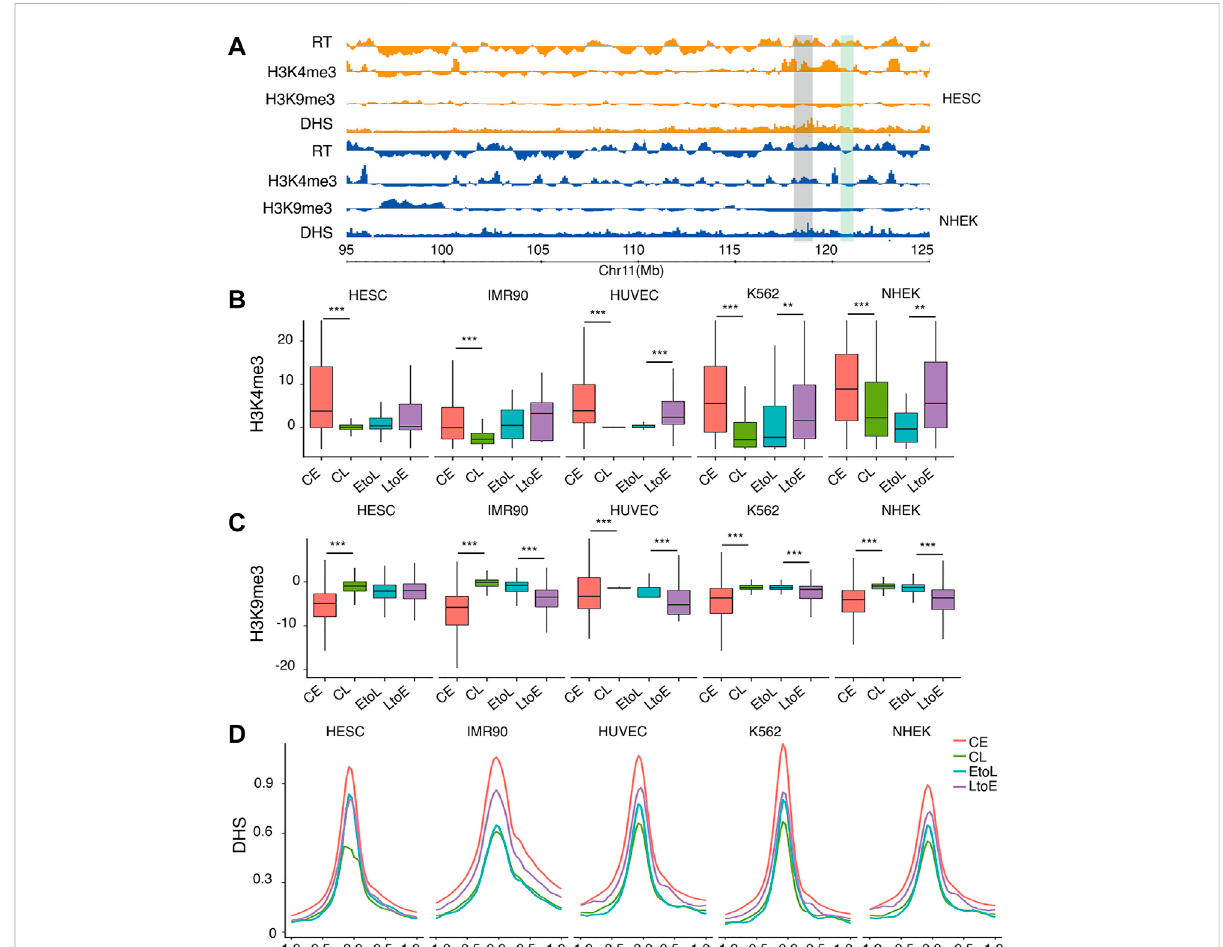
FIGURE 2 Epigenetic features of the four RT classes. (A) Typical region on chromosome 11 showing replicating time, H3K4me3, H3k9me3, and DNase I hypersensitivity sites (DHSs) for hESC and NHEK cells. The region highlighted in gray denotes an area with constitutive early RT. The region highlightedingreendenotesanareawithRTswitchingfromearlytolate. (B) H3K4me3signaldistributionofthefourreplicationdomains:constitutive early (CE), constitutive late (CL), early-to-late (EtoL), and late-to-early (EtoL). The CE and CL regions differ signi fi cantly in all cell types. The EtoL andLtoEregionsshowsigni fi cantly differentsignalsindifferentiatedcells. (C) H3K9me3signaldistributions. TheCEandCLregionsdiffersigni fi cantly in all cell types studied. The EtoL and LtoE regions show signi fi cantly different signals in differentiated cells (D) DHS pro fi le anchored at TSS within 1.0 kb upstream and downstream. p values are calculated using Wilcoxon rank-sum tests. ** p < 1e-5, *** p <